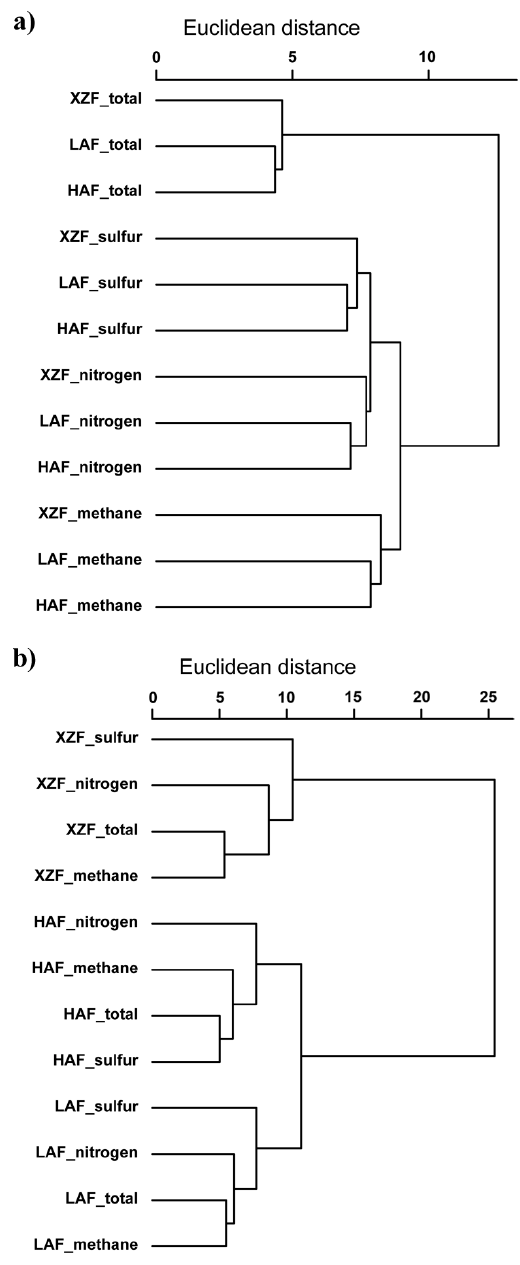
Figure 7. Agglomerative hierarchical clustering for the presence/absence ( a ) and relative abundance ( b ) of sequences grouped by phylogenetic families for both the total and the metabolic cycles analyzed of each sampled site. Euclidean distance matrix and UPGMA algorithm were used for this analysis.